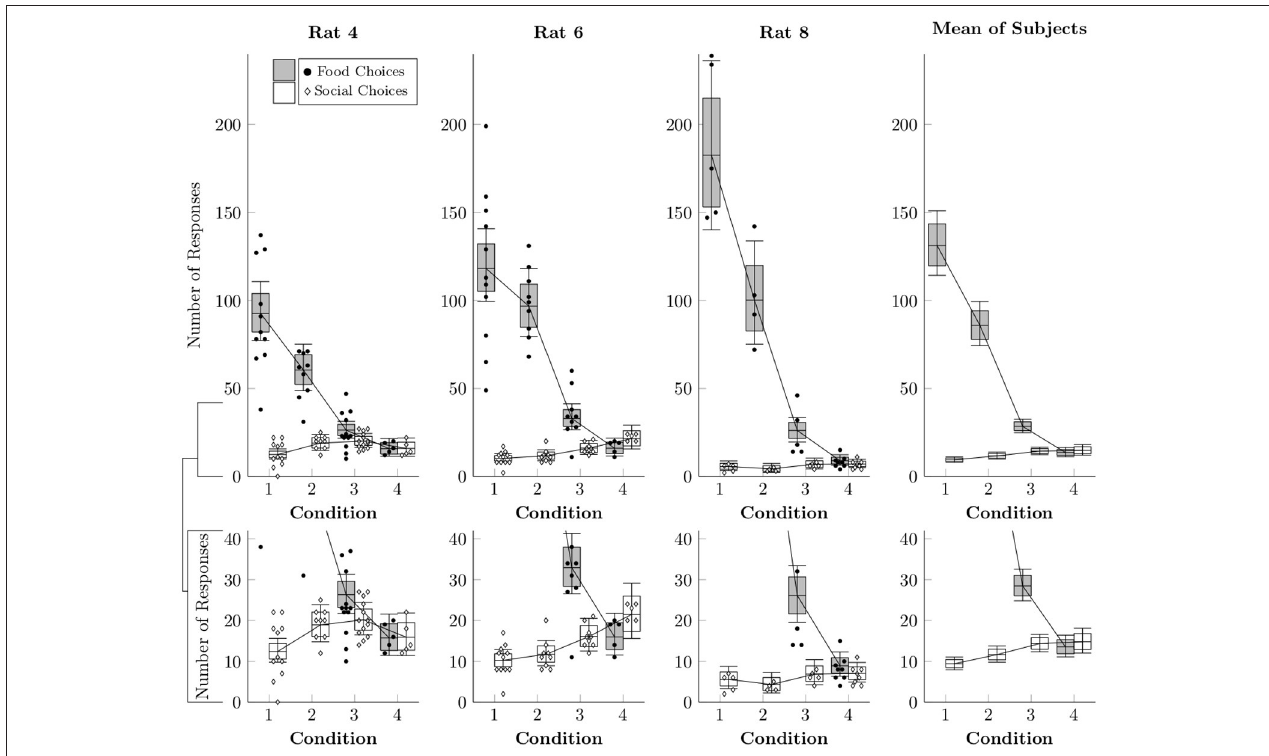
FIGURE 3 | Estimated rates at which food choices (black circles) and social choices (white diamonds) were made for each of the rats in Conditions 1–4 based on a multi-level negative binomial regression, as well as observed event counts. Points represent event counts for each session, whereas boxes represent the 80% credible interval and whiskers represent the 95% credible interval of the estimated